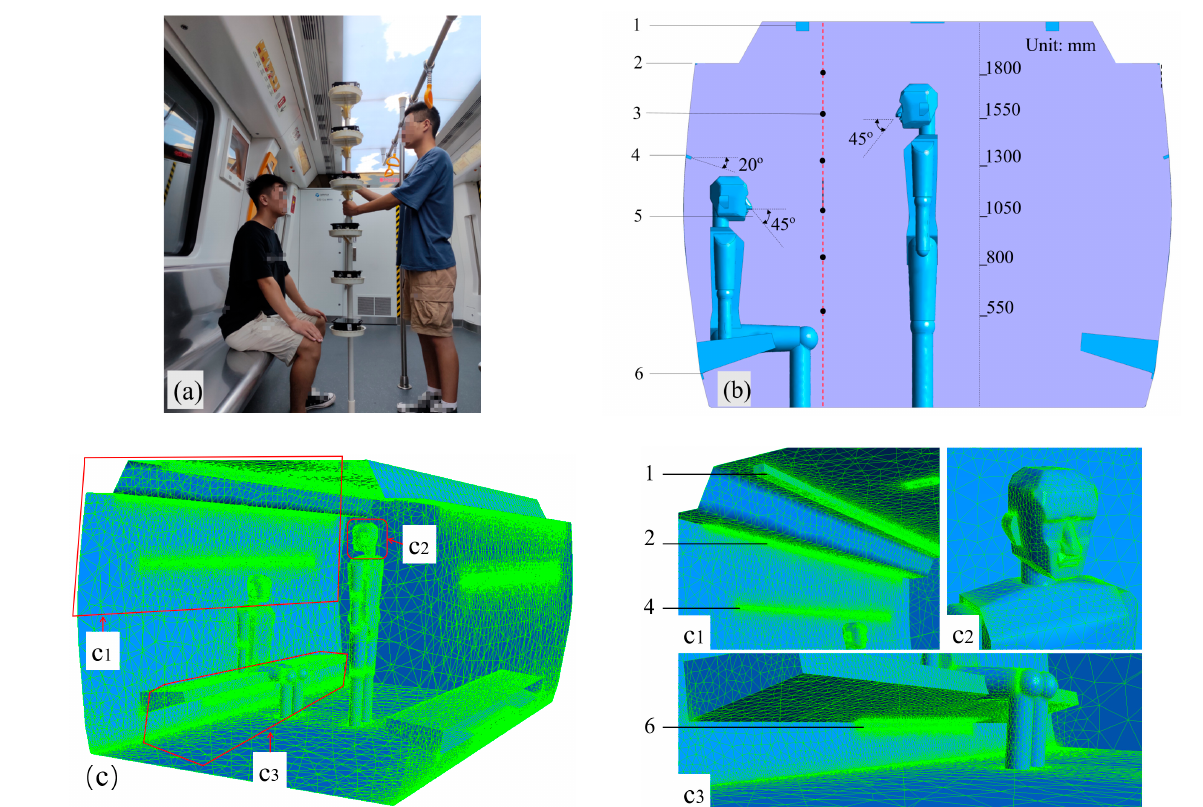
Figure 2. ( a ) Photograph of the field experiment and ( b ) layout of subway car ventilation system and monitoring points. ( c ) The global grid and local grid element of a carriage. ( c1 ) Grid information and